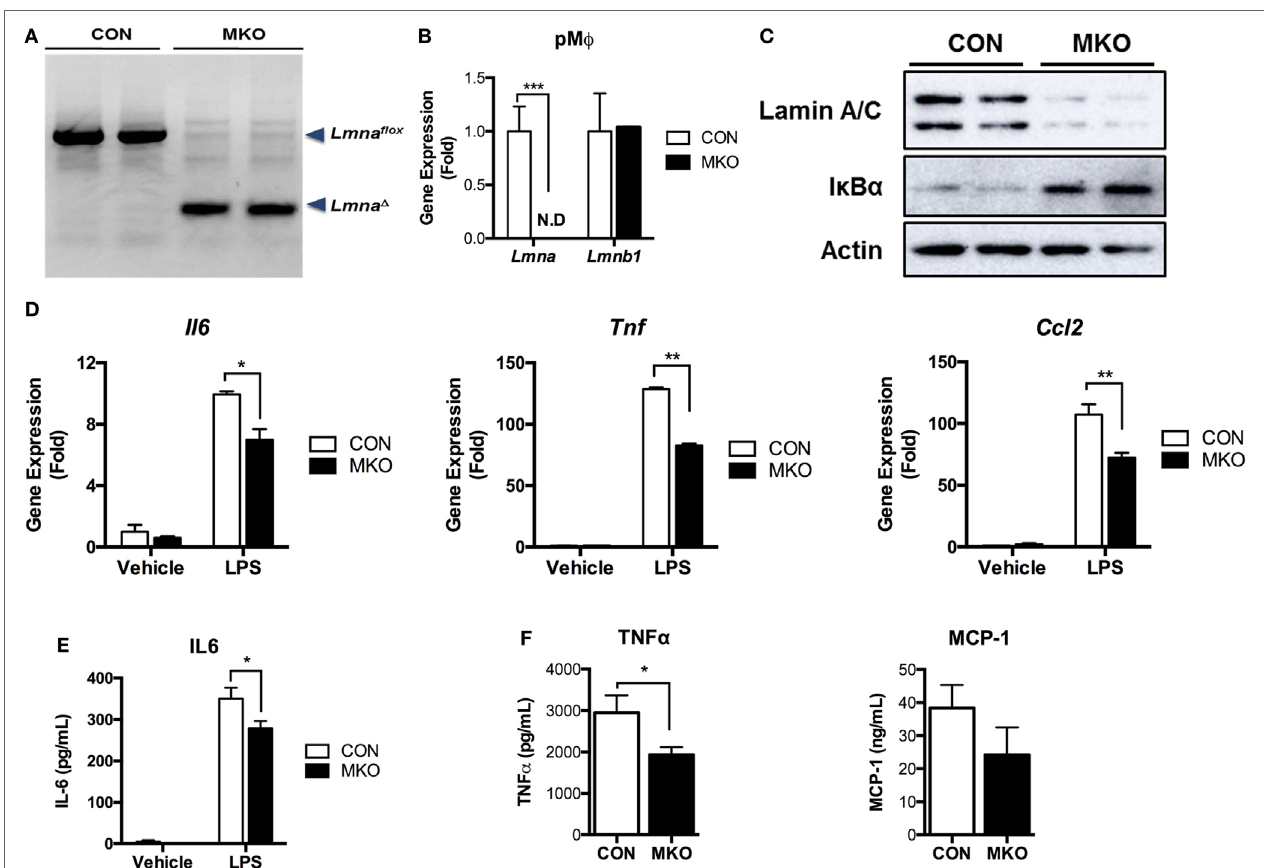
FigUre 5 | Depletion of lamin A/C suppresses proinflammatory gene activation upon LPS treatment in macrophages. (a–e) Analyses of peritoneal macrophages from control and myeloid cell-specific Lmna KO mice (MKO) mice. (a) PCR genotyping of peritoneal macrophages from WT control (CON, Lmna flox/flox ) and MKO (LysM-Cre; Lmna flox/flox ) mice. Arrowheads mark Lmna flox (uncleaved) and Lmna Δ (cleaved) alleles. (B) qRT-PCR analysis of Lmna and Lmnb1 in peritoneal macrophages isolated from CON and MKO mice. (c) Immunoblots of lysates from peritoneal macrophages for lamin A/C (top), I κ B α (middle), or actin (bottom). (D,e) Peritoneal macrophages were isolated from control and MKO mice and then treated with vehicle or 10 ng/ml LPS for 2 h. (D) qRT-PCR analysis of Il6, Tnf, and Ccl2 in peritoneal macrophages isolated from CON and MKO mice. (e) Level of IL-6 in supernatant of CON and MKO peritoneal macrophages treated with vehicle or 10 ng/ml LPS for 6 h. (F) Plasma TNF α and MCP-1 levels after i.p. injection of LPS (20 mg/kg BW) were measured in CON and MKO mice ( n = 6 per group). Error bars represent SEM. * p < 0.05, ** p <